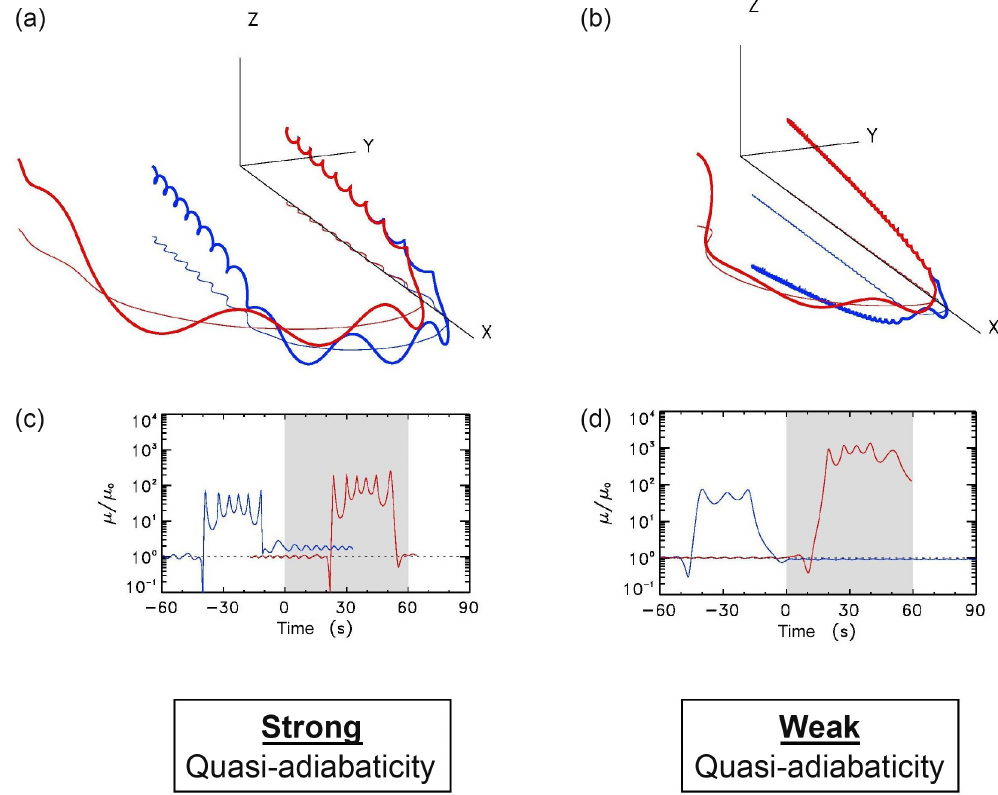
Figure 9. Model H + orbits illustrating (left) the case of “strong” quasi-adiabaticity and (right) the case of “weak” quasi-adiabaticity. Top and bottom panels show three-dimensional views of the H + trajectories and magnetic moment versus time, respectively. The test protons coded in blue and in red cross the field reversal before and during dipolarization, respectively. Thin lines in the top panels show the trajectory projections in the equatorial plane. A 60s magnetic transition is